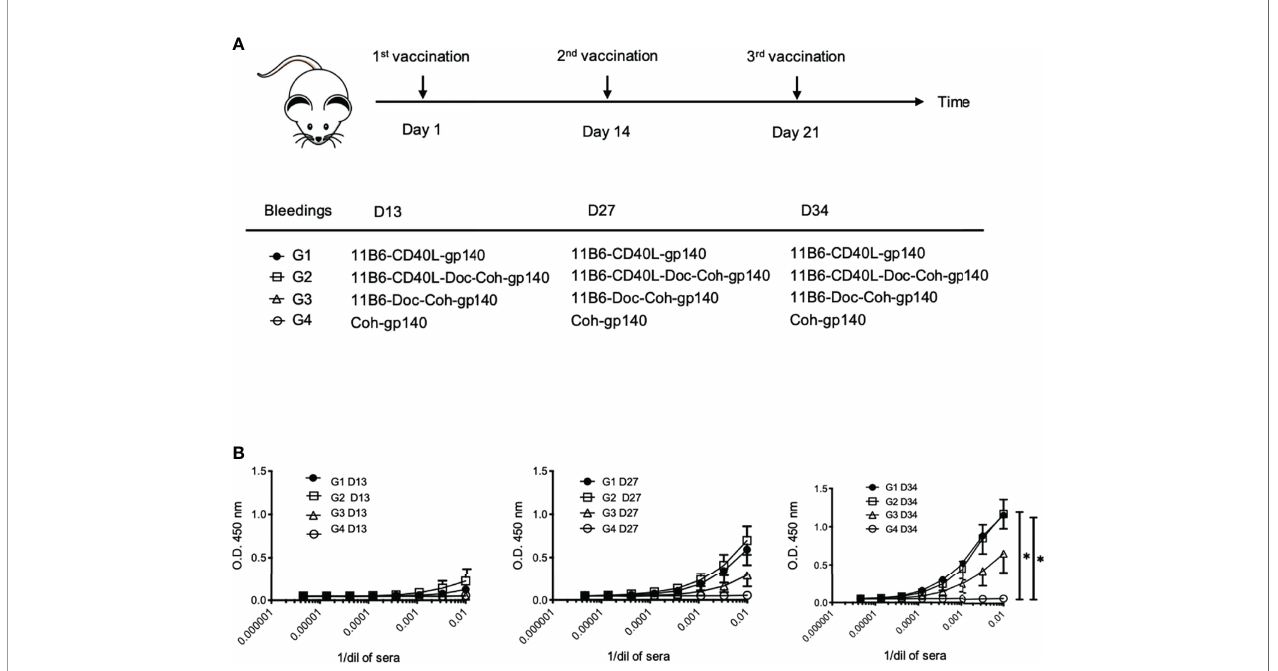
FIGURE 9 | CD40-targeted HIV-1 gp140 antigen with fused CD40L elicits superior gp140-speci fi c serum IgG responses in human CD40 transgenic mice. (A) Human CD40 homozygous transgenic mice were vaccinated via intraperitoneal injection with (Group 1) anti-CD40 11B6-CD40L directly fused to HIV-1 gp140, (Group 2) anti- CD40 11B6-CD40L-Dockerin + Cohesin-gp140, (Group 3) anti-CD40 11B6-Dockerin + Cohesin gp140, or (Group 4) Cohesin-gp140. Dose was normalized to be the molar equivalent of 1 m g of the Group 2 vaccine, except for the non-targeting control Group 3 (2 m g or ≅ 3 molar equivalents). Vaccination was at Day 1, Day 14, and Day 21 with small blood draws taken at Day 13 (D13), Day 27 (D27), and Day 34 (D34). (B) The graphs show serial dilutions of sera analyzed for anti-gp140 IgG reactivity by ELISA as described in (16) except that anti-mouse IgG-HRP reagent was the detecting reagent. Group sizes were G1, n=3 and G2-4, n=4. Directional error bars are S.E. of the mean. * indicates a statistically signi fi cant difference of